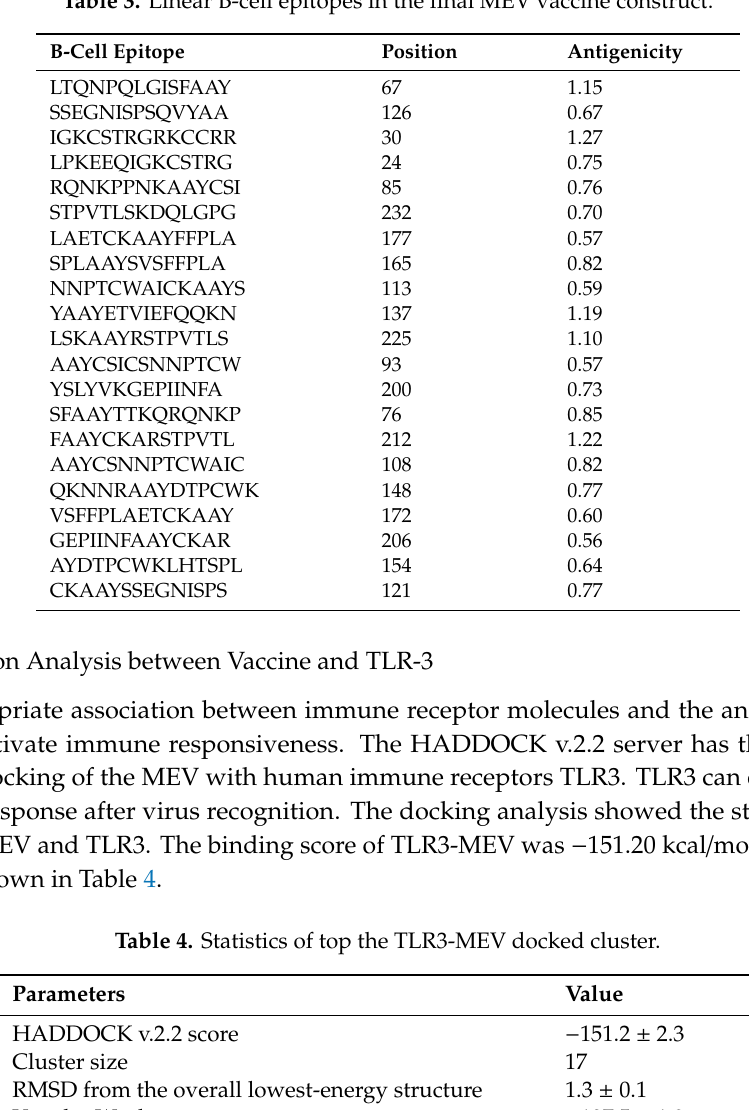
Table 3. Linear B-cell epitopes in the final MEV vaccine construct.